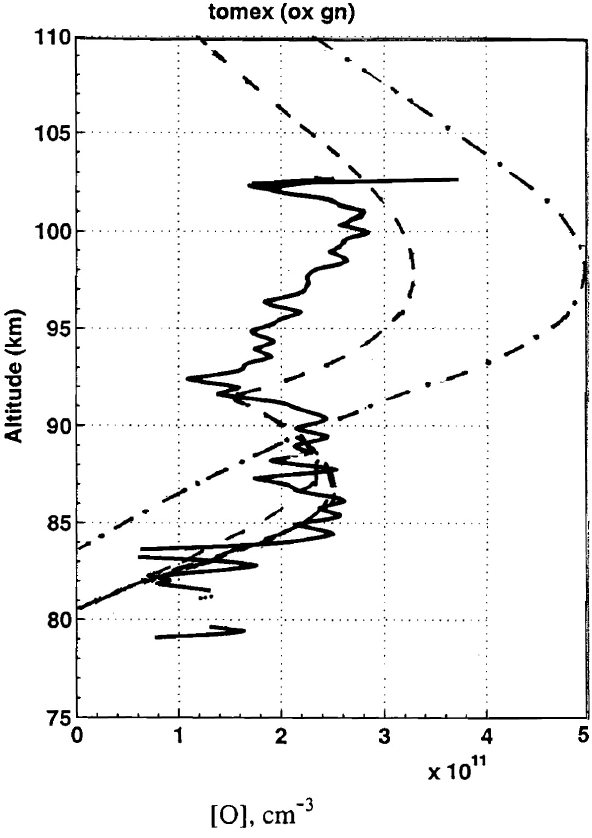
Fig. 11. Height profiles of atomic oxygen density inferred from the green line emission measured during the TOMEX (solid line), calculated by the model (dashed line), and given by the MSISE-90 model (dashed-dotted